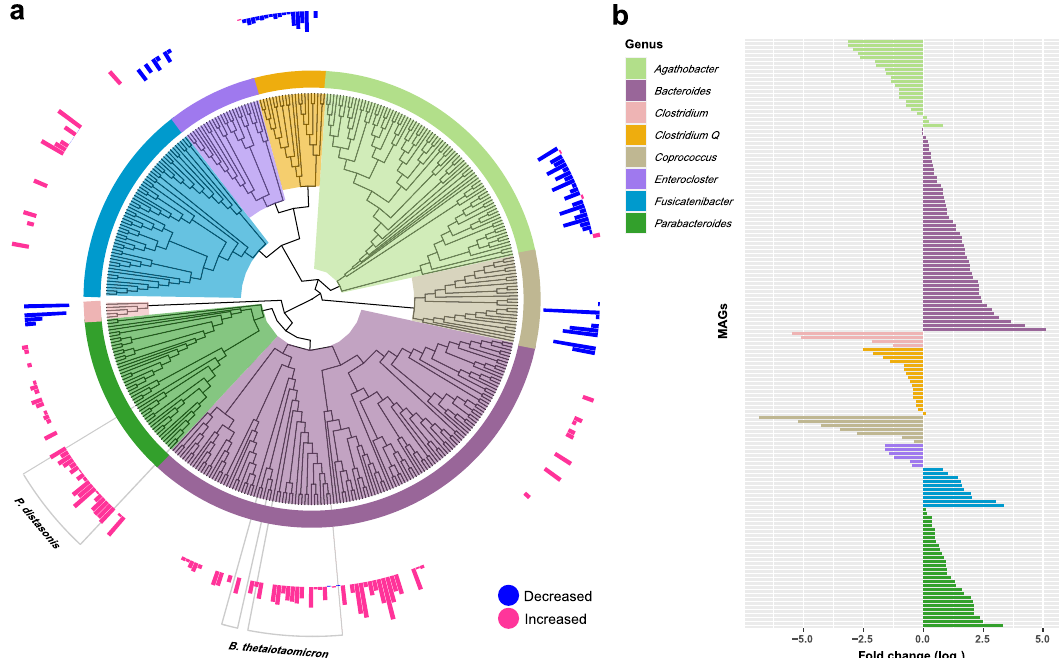
Fig. 2 Changes in the taxonomic composition of the gut microbiota after IF intervention. a Phylogenetic tree of genera in which only metagenome-assembled genomes (MAGs) either enriched before or after the intervention are included. The bar-plot circle outside represents the fold change of the MAGs. The magenta bar indicates signi fi cant enrichment after the intervention, whereas the blue bar indicates a decrease in abundance after the intervention (adjusted p < 0.05, paired Wilcoxon test). The tree was constructed by PhyloPhlAn (v3.0.51) and visualized by ggtree (v5.6.2). b Fold change of the MAGs enriched either before or after the intervention. The MAGs with a fold change less than zero were enriched before the IF intervention, and those with values above zero were enriched